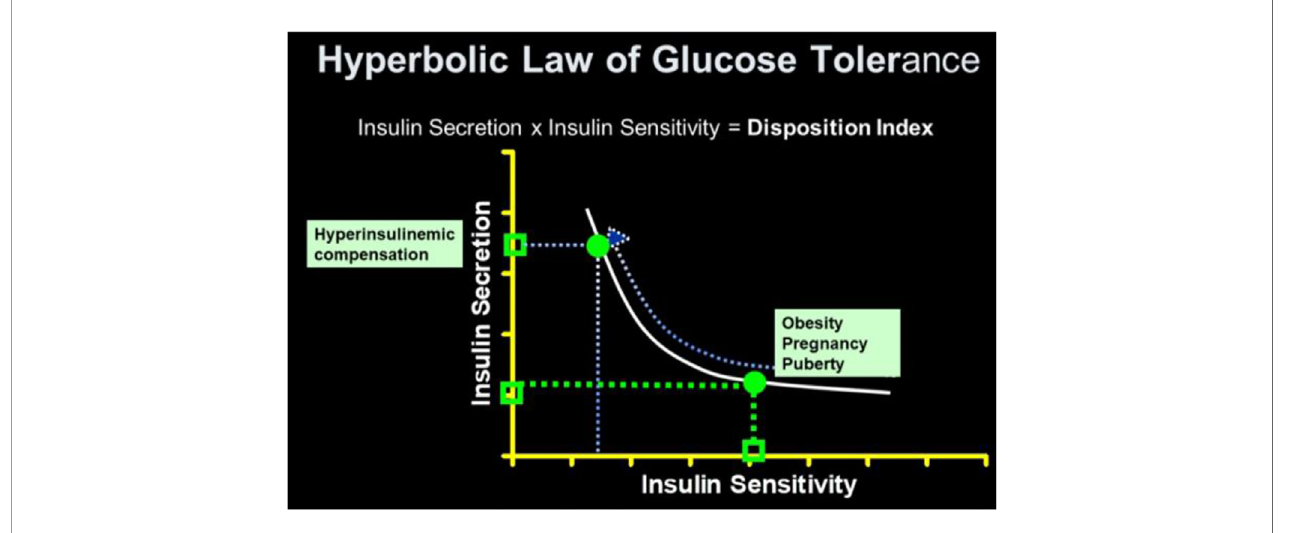
FIGURE 12 | Disposition index